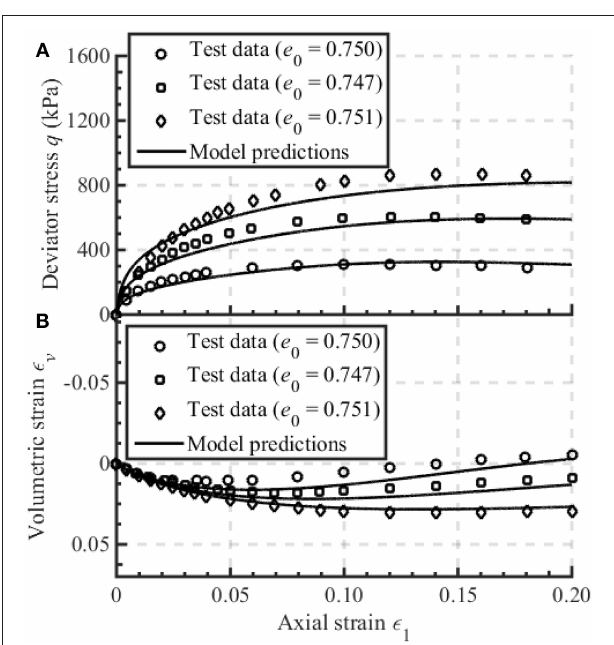
FIGURE 2 | Model prediction of the drained monotonic behavior of Fuji River sand (Ishihara et al., 1975): (A) deviator stress vs. axial strain, (B) volumetric strain vs. axial